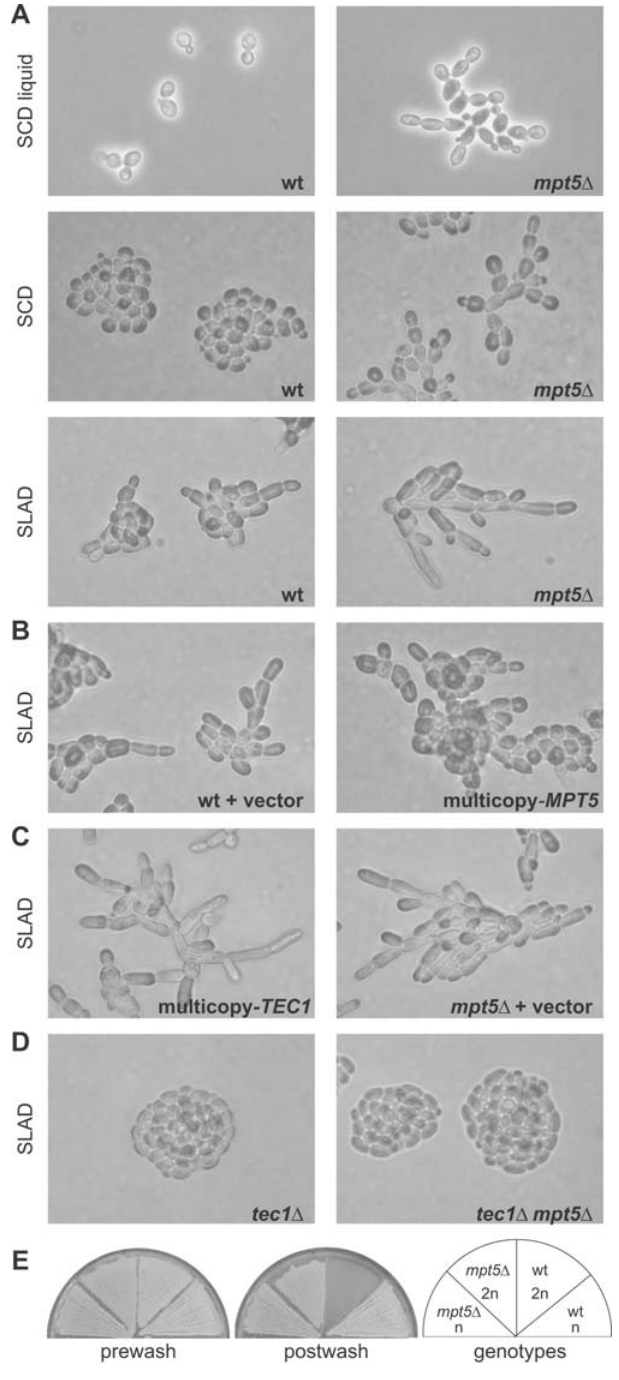
Figure 1. Repression of yeast filamentous-form phenotypes by MPT5 . (A–D) Diploid yeast were grown under yeast-form conditions (SCD liquid and SCD) or filamentous-form conditions (SLAD) and microscop- ically imaged. (E) Patches of yeast were grown on rich medium agar and subjected to a washing-off assay of adhesion.